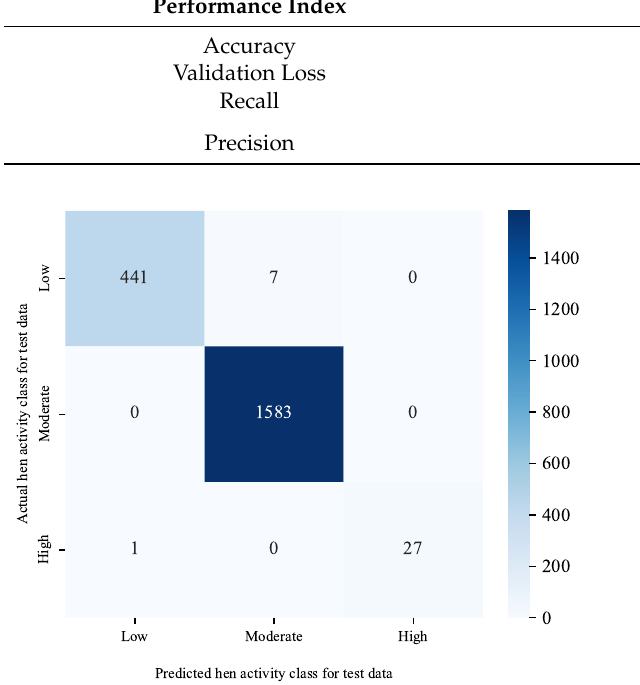
Figure 15. Confusion matrix for the experiment in which the AVM data bundle of blue hen is used for both training and testing of the LeNet5